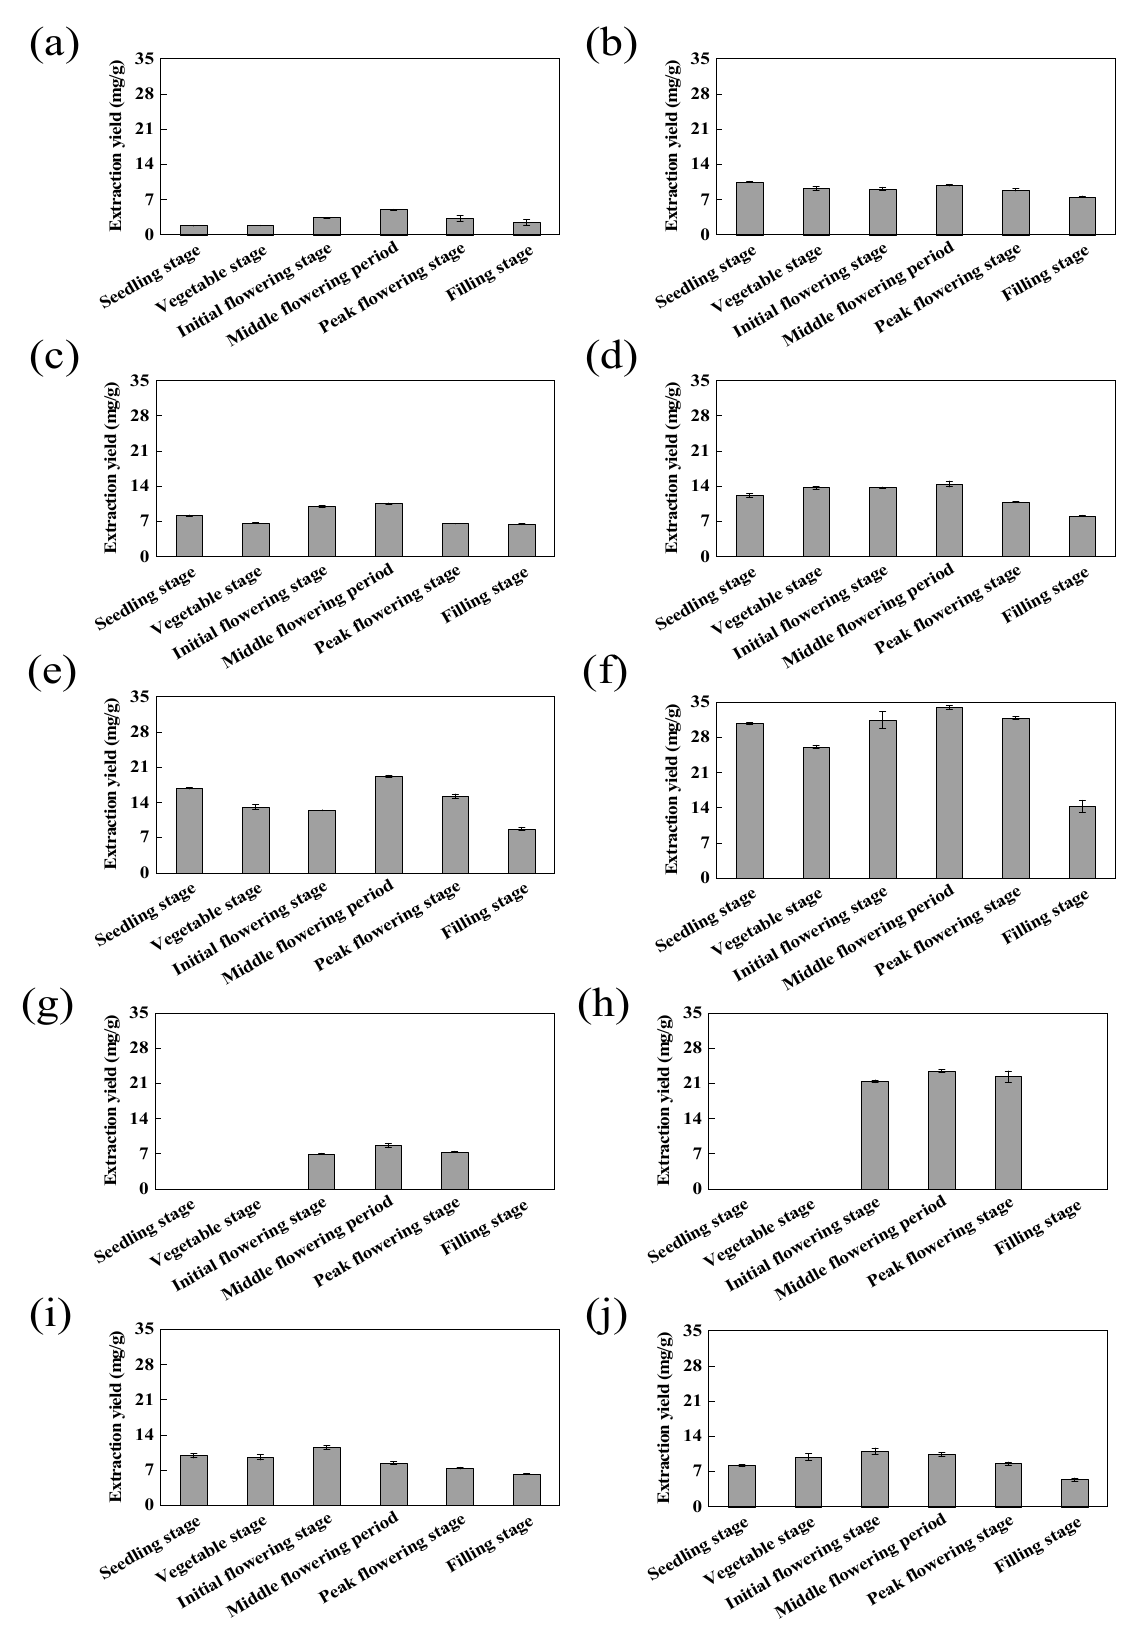
Figure 4. Analysis of TTC from fresh Lactuca indica samples ( a )—roots; ( c )—stems; ( e )—leaves; ( g )—flowers; ( i )—whole plants) and dried Lactuca indica samples ( b )—roots; ( d )—stems; ( f )—leaves; ( h )—flowers; ( j )—whole plants).